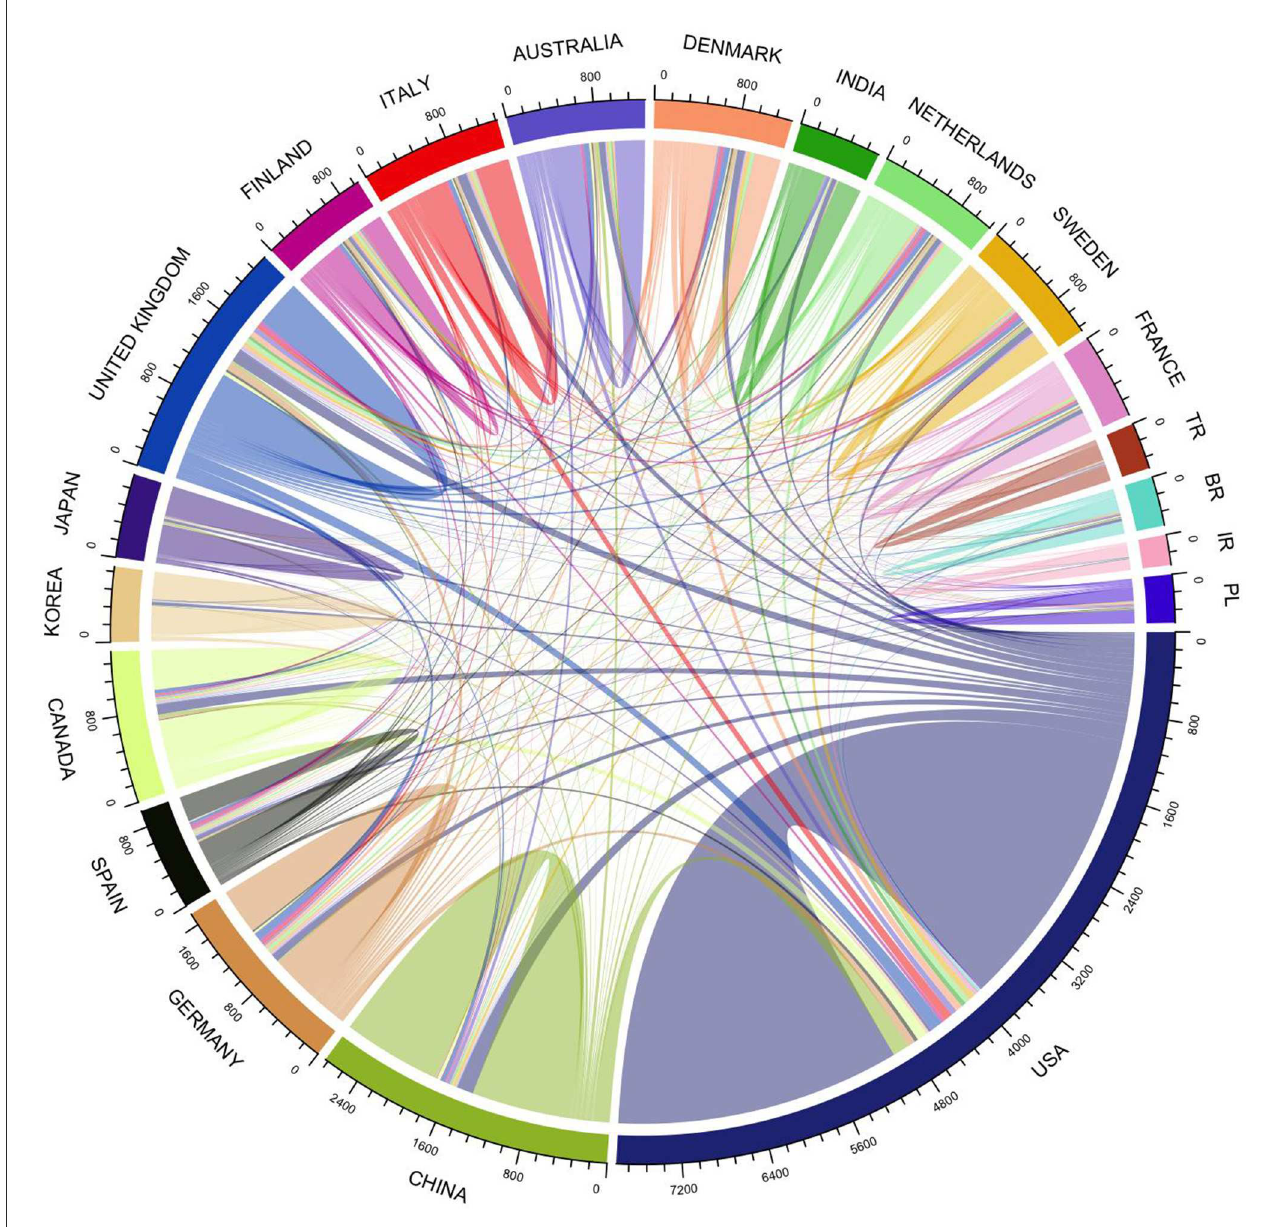
FIGURE9 Country collaboration